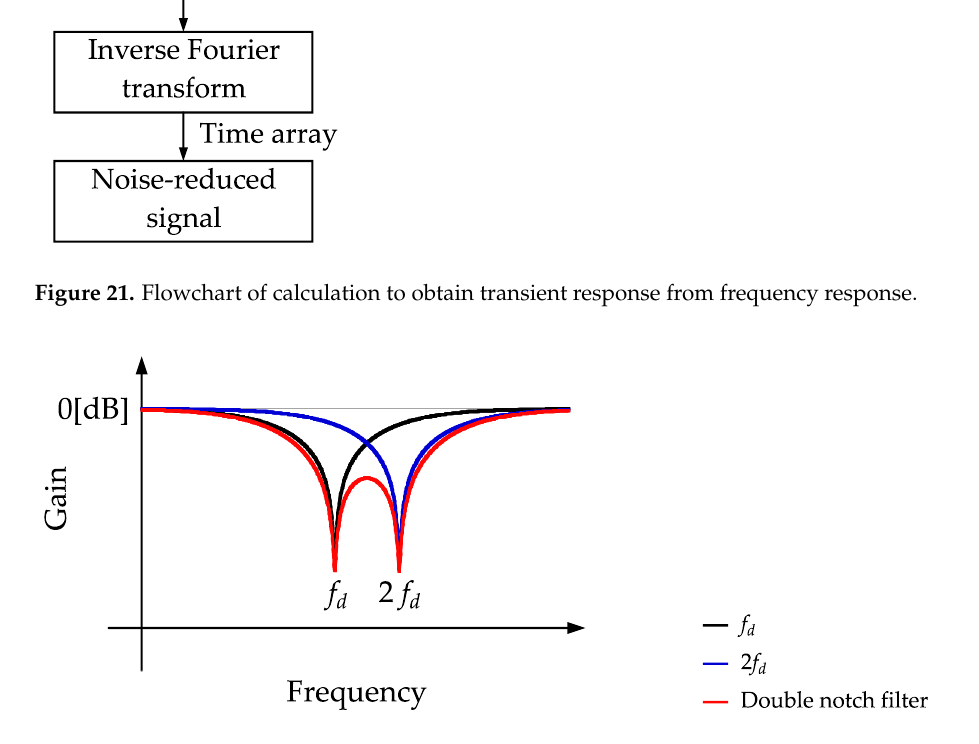
Figure 22. Schematic view of frequency responses. The transfer function of the double-notch filter is given by the product of a filter with an elimination frequency of f d and that of a filter with an elimination frequency of 2 f d .